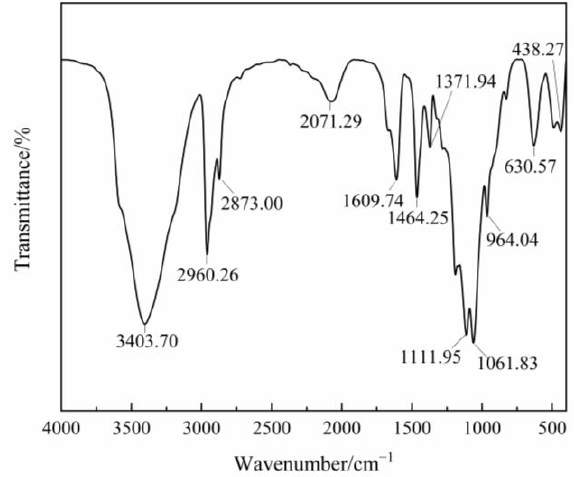
Figure 5. The infrared spectrum of the product.